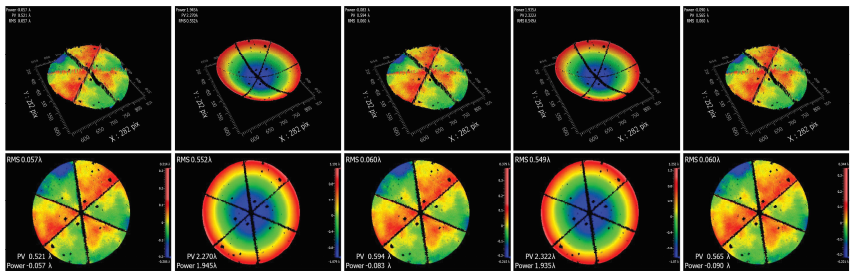
Figure 8. The AR was actuated from the flat state to a compressed state (or convex surface) and back to flat. For each case the top row is the 3D surface and the bottom row the 2D surface.